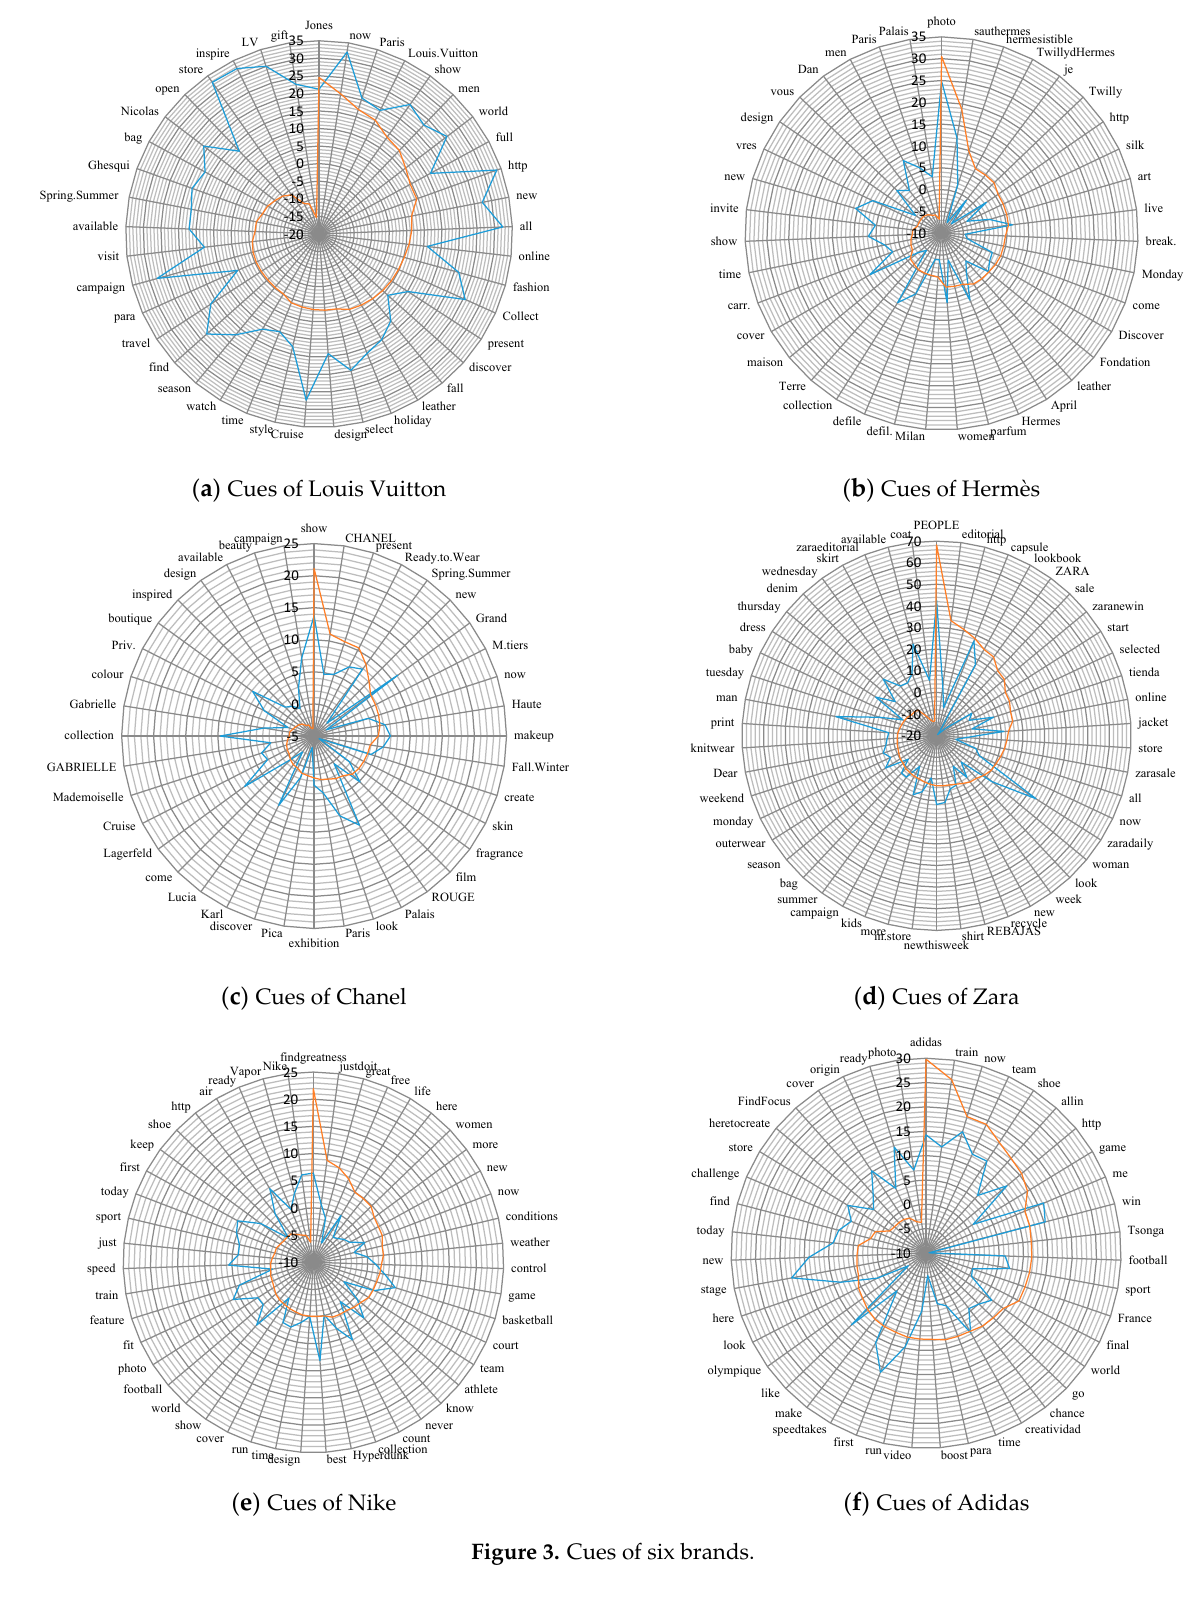
Table 2. ( a ) Linear regression coefficient of determination and beta (luxury fashion brands), ( b ) Linear regression coeffi- cient of determination and beta (fast fashion brands).